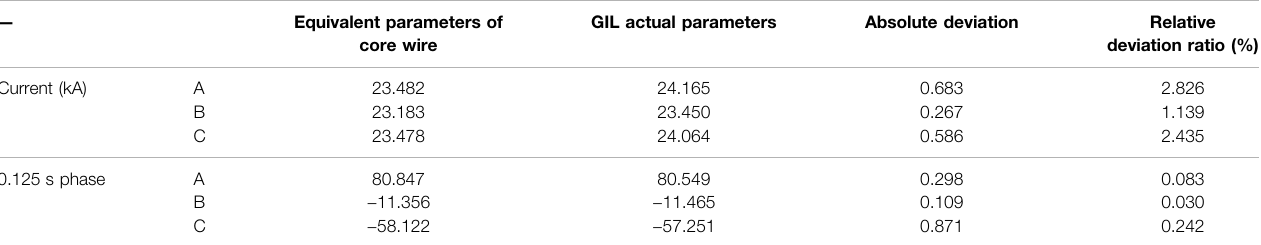
Relative deviation ratio (%)